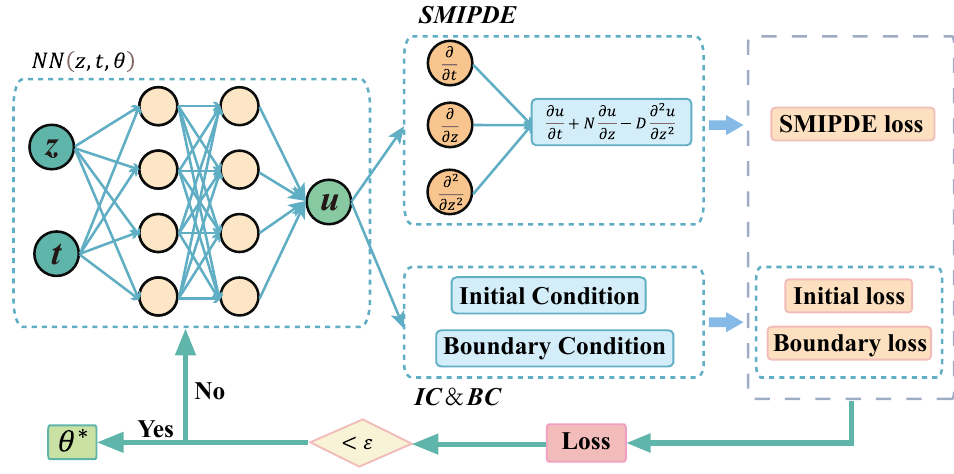
Figure 3. The principle of the soil moisture infiltration equation solution